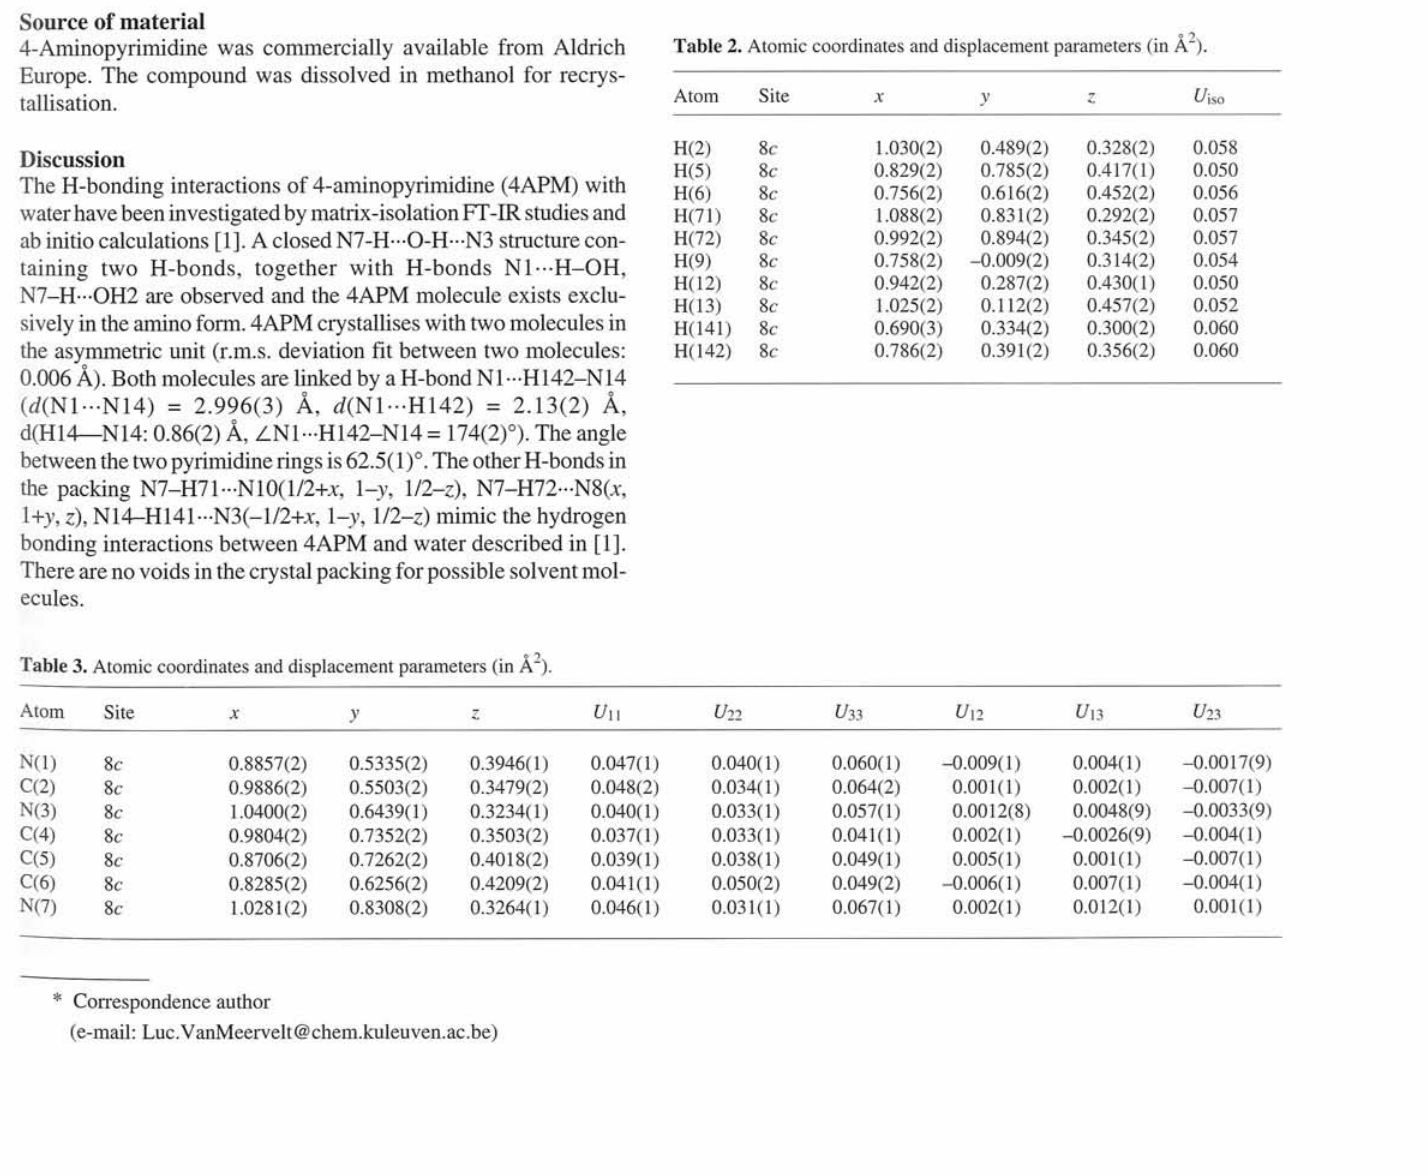
Table 2. Atomic coordinates and displacement parameters (in A").